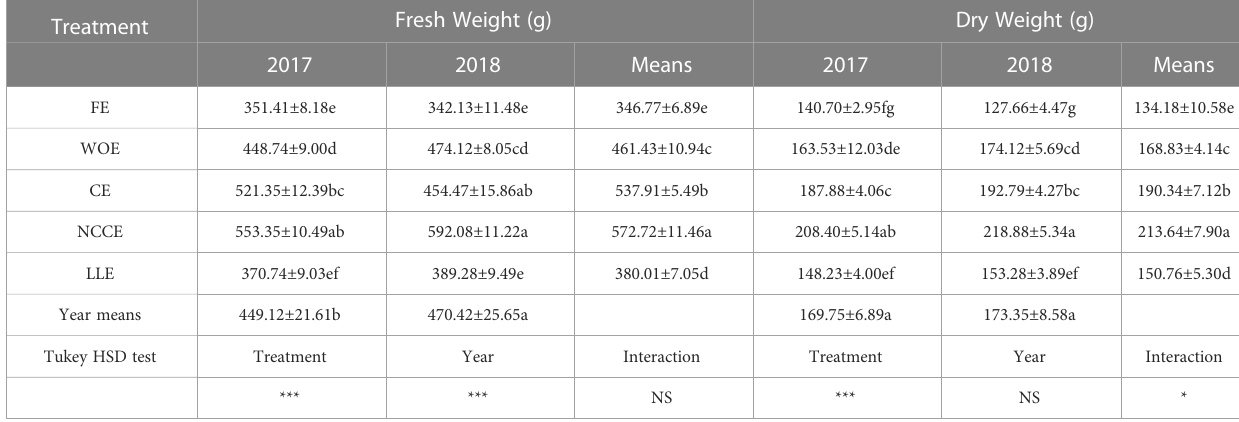
TABLE 7 Effect of different leafy vegetable rotation systems on fresh and dry weight of eggplant during the year 2017 and